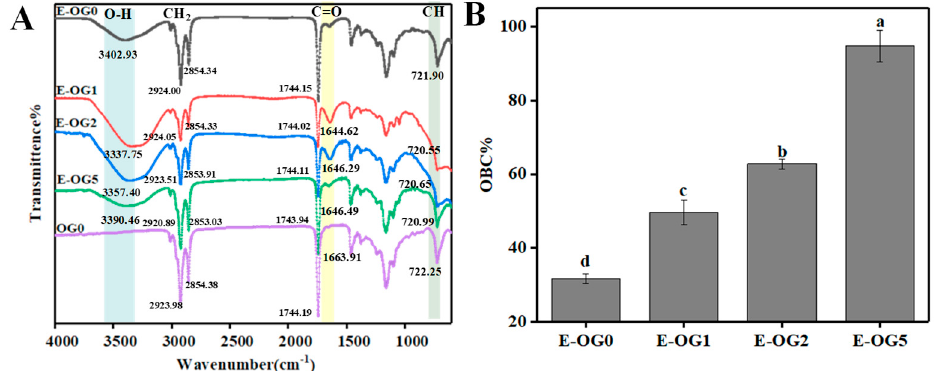
Figure 5. FTIR( A ) and oil binding capacity( B ) of W/O emulsions with different content of GMS. Figure 5. FTIR ( A ) and oil binding capacity ( B ) of W/O emulsions with different content of GMS. Different lowercase letters represent significant differences. ( p < 0.05). Different lowercase letters represent significant differences. ( p <